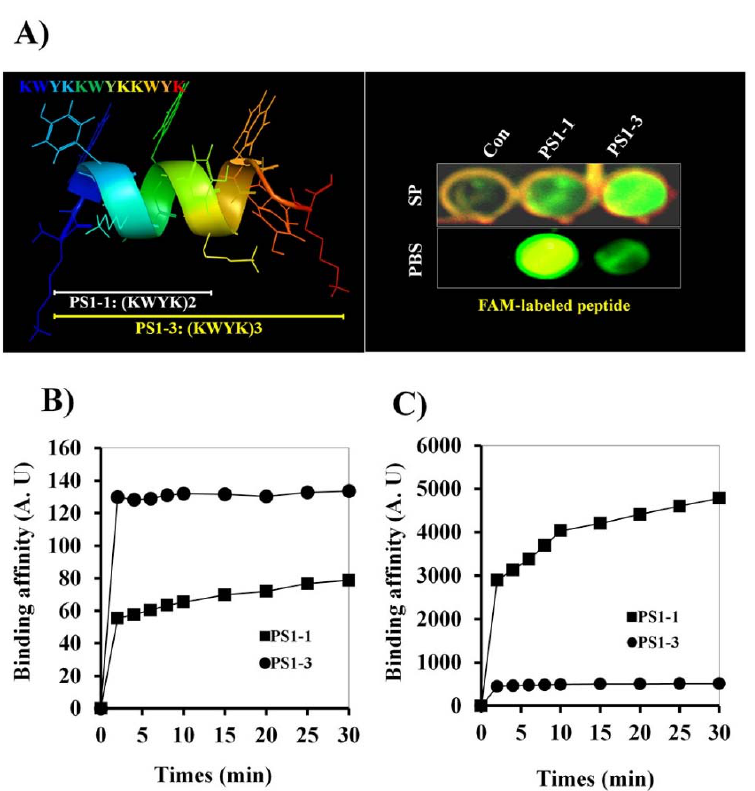
Figure 1. Binding affinity effects of FAM-labeled PS1-1 and PS1-3 peptides against C. albicans . PS1-3 peptide structure was modeled using the PEP-FOLD server (http://mobyle.rpbs.univ-paris-diderot.fr/cgi-bin/portal.py#forms::PEP-FOLD, accessed on 10 September 2021) ( A ). At the 1/2 MFC, binding effects of PS1-1 and PS1-3 FAM-labeled peptides on the membrane of C. albicans (5 × 10 5 cells/mL) ( B , C ). FAM-labeled PS1-1 and PS1-3 peptides were incubated with C. albicans at room temperature ( B : SP buffer, C : PBS buffer). All values represent three individual experiments.